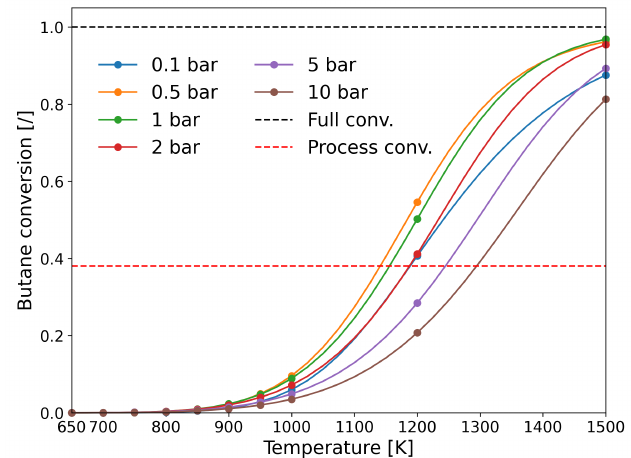
Figure 14. Butane conversion from MKM simulations at different operating conditions (temperature and pressure). Red dashed line shows the industrial conversion using the C ATADIENE ® technology. (Reprinted with permission from